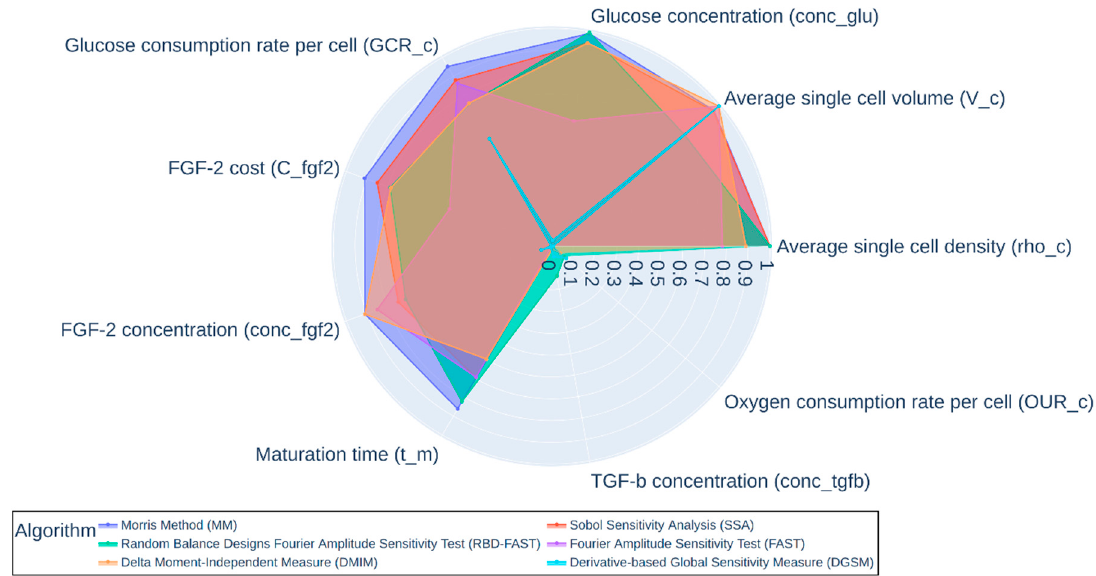
Figure 4. ACBM sensitivity analysis of key model variables.